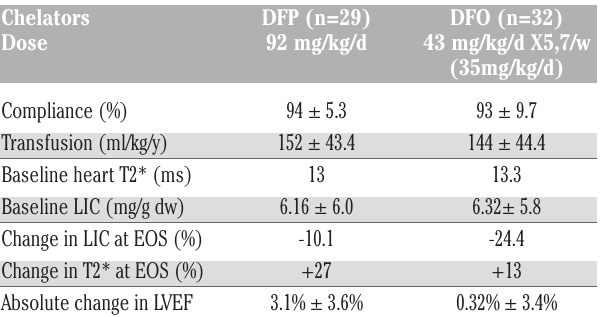
Table 7. Description of the study group at baseline and the change in liver and myocardial T2* at the end of study (Data from Tanner MA, et al. Circulation. 2007; 115:1876-84).